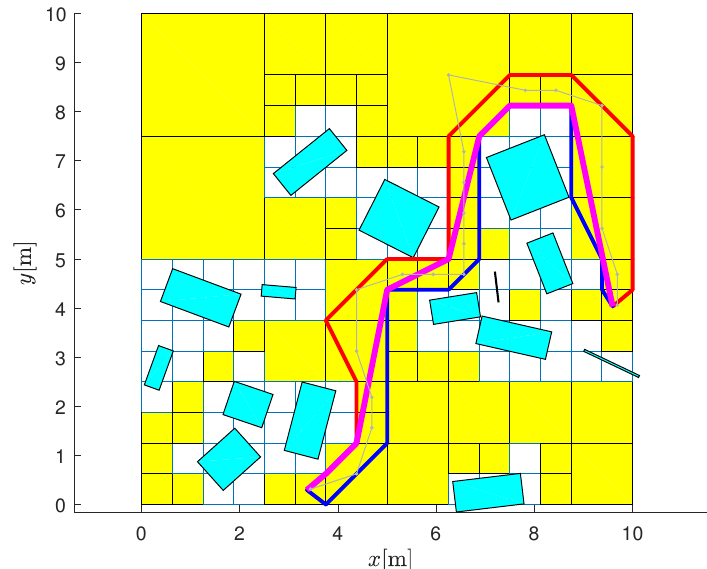
Figure 6. Example 2: environment with random obstacles, decomposed into square cells with quadtree decomposition, with the starting position in the cell at the bottom left. The optimal path connecting the centres of the free cells is determined by the A ∗ algorithm (grey line). A safe corridor is identified (red and blue line) within which an optimised path with straight segments is determined using the funnel algorithm (magenta